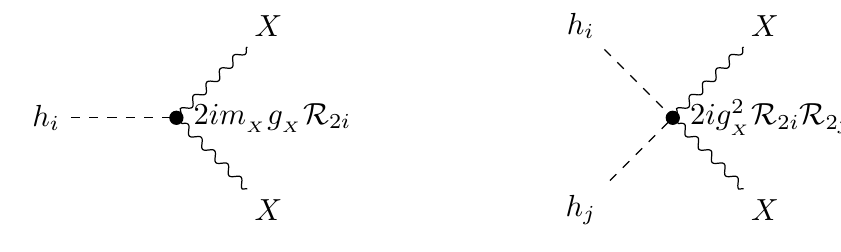
Figure 2 . The vertices relevant for the VDM